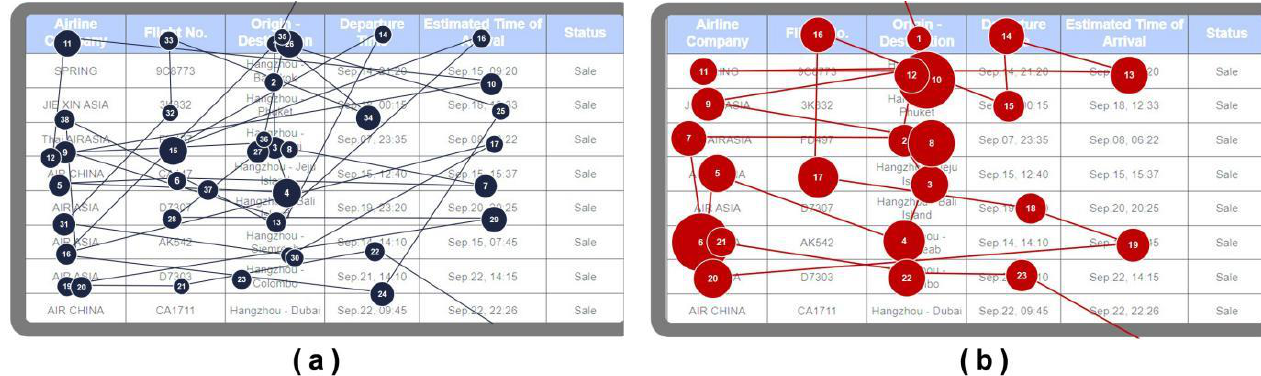
Figure 7. A comparative visualization of eye fixation trajectory in different-sized groups: ( a ) the eye fixation trajectory in a large group of the 6th form; ( b ) the eye fixation trajectory in a small group of the 2nd form.